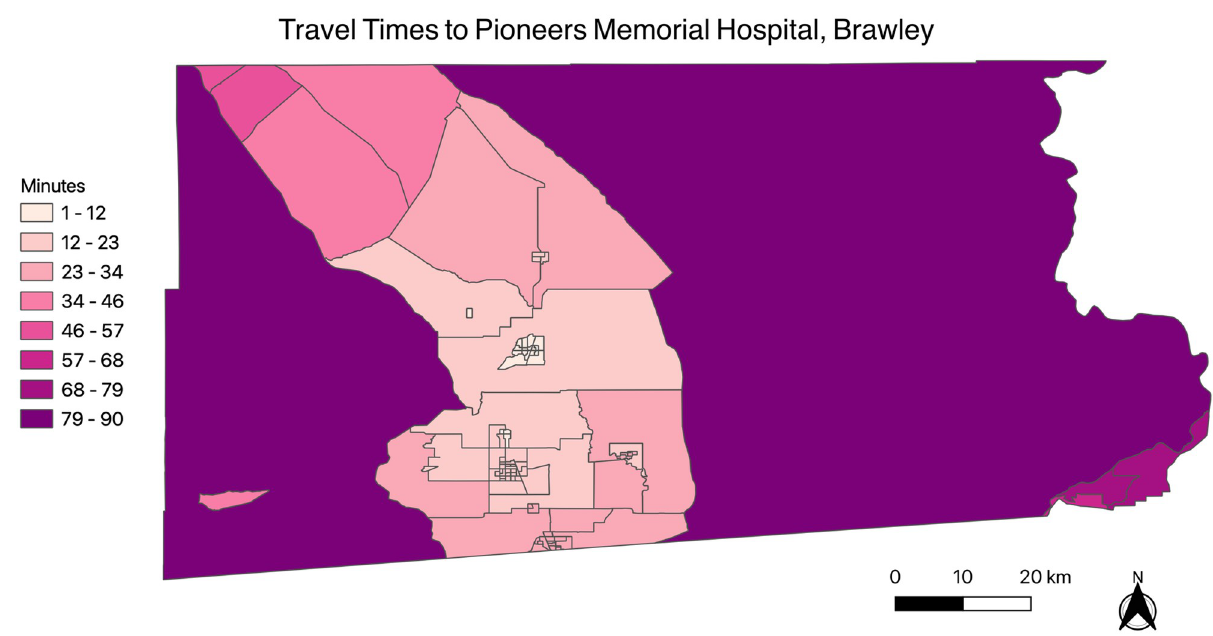
Fig 1. Travel times between Imperial County census tract centroids and Pioneers Memorial Hospital, Brawley. The map was generated using the free and open-source software QGIS version 3.14 (http://www.qgis.org/en/site/about/index.html).